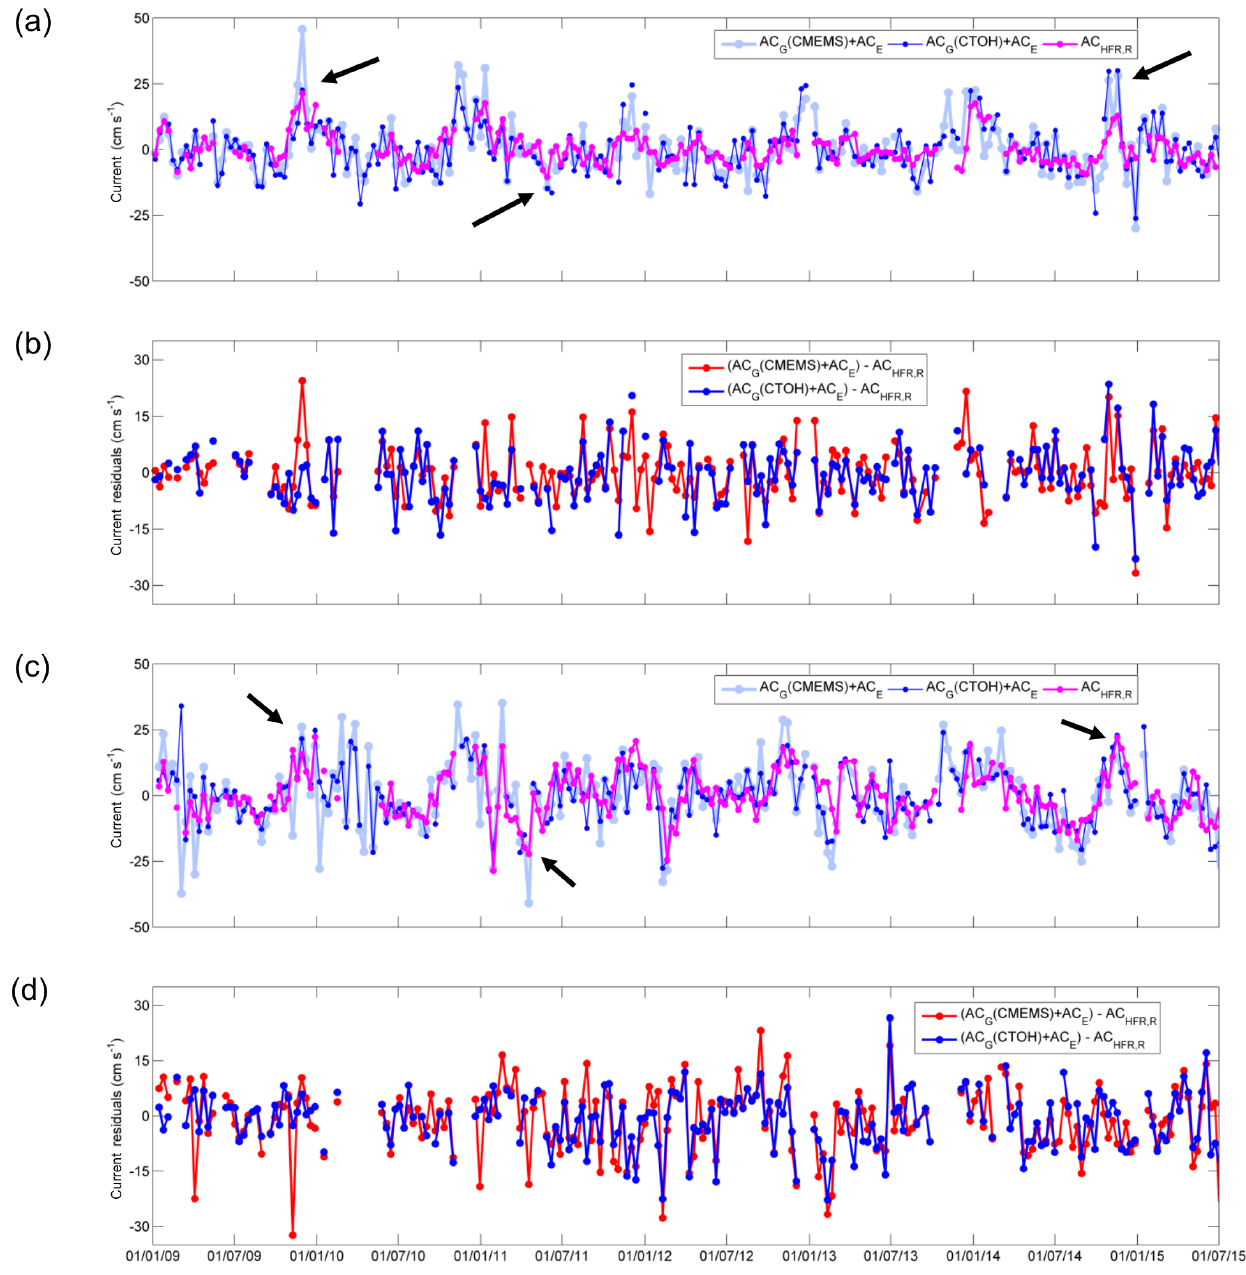
Figure 3. Across-track AC G + AC E and AC HFR , R . (a) CTOH, CMEMS, and HFR data sets at point E R . (b) CTOH-HFR and CMEMS-HFR residuals at point E R . (c) CTOH, CMEMS, and HFR data sets at point W R . (d) CTOH-HFR and CMEMS-HFR residuals at point W R . Black arrows depict the slope current intensifications mentioned in the